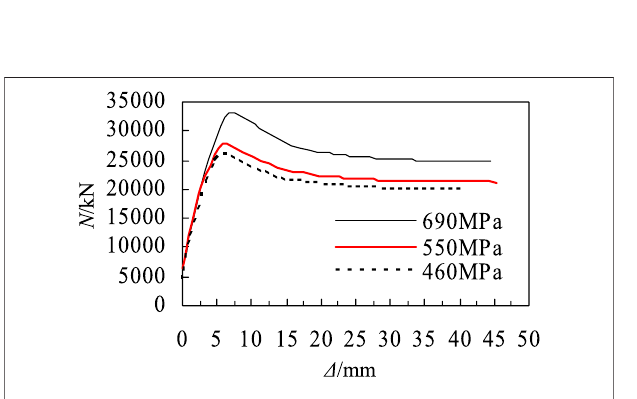
FIGURE 11 | The in fl uence of f y on the N - Δ curve. FIGURE 12 | The in fl uence of f cu on the N - Δ